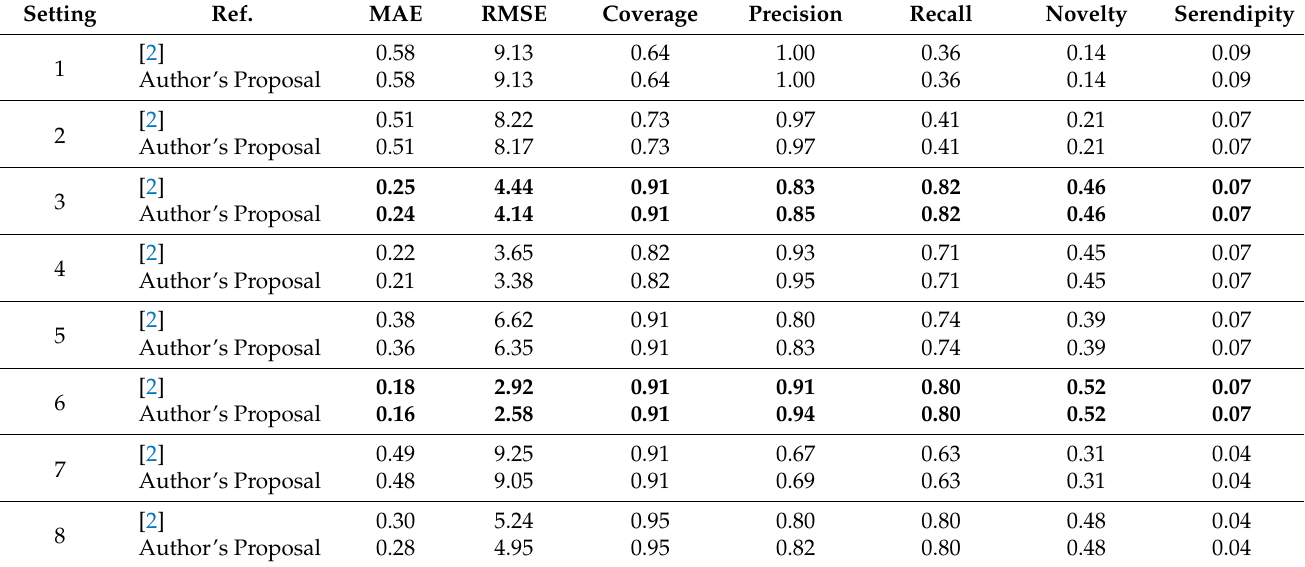
Table 6. Metrics for the different RS configurations used to train data.